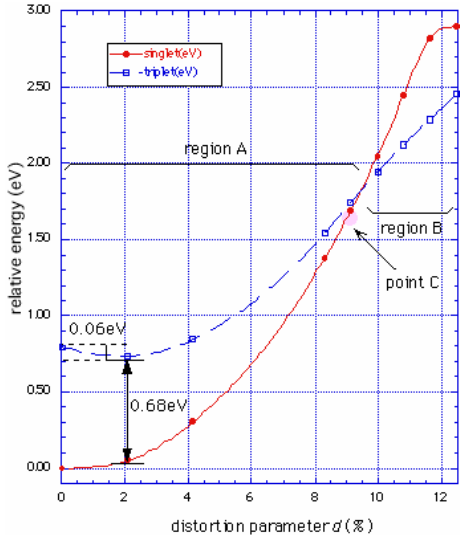
Figure 7. S-T gap of Rh-C with variation of C cage distortion. The information of 60 60 region and point are in the